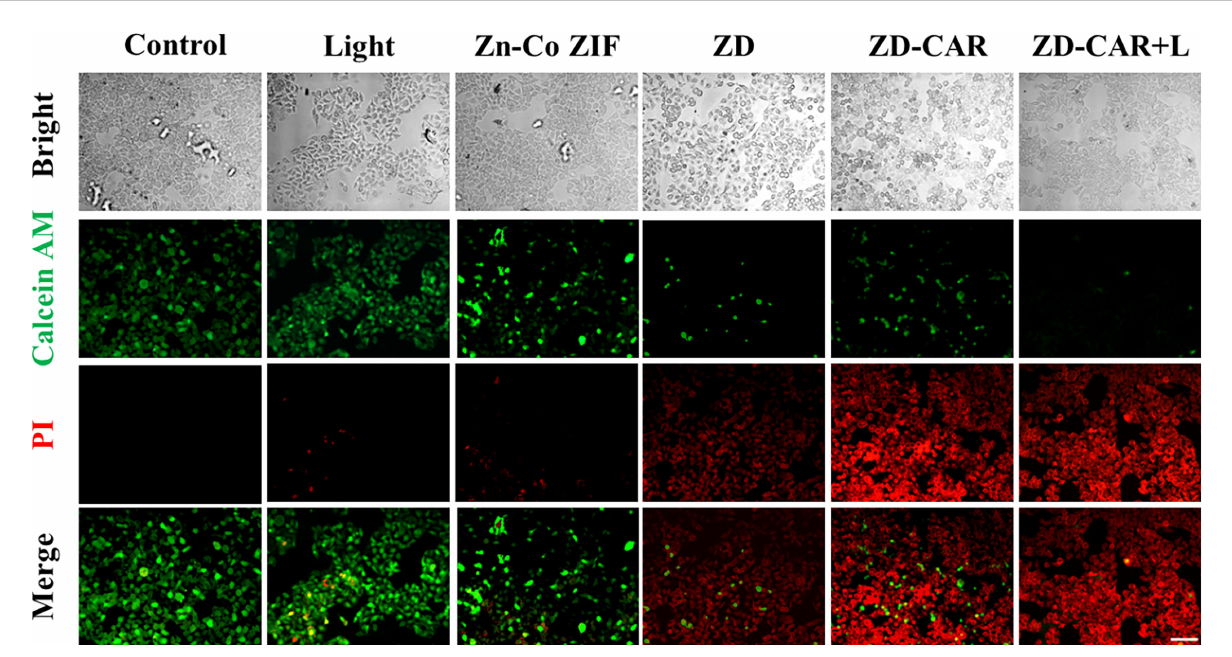
FIGURE 9 HepG 2 cells treated with different materials were double stained with Calcein AM/PI (incubate for 24 hours). Scale bar is 100 m m.